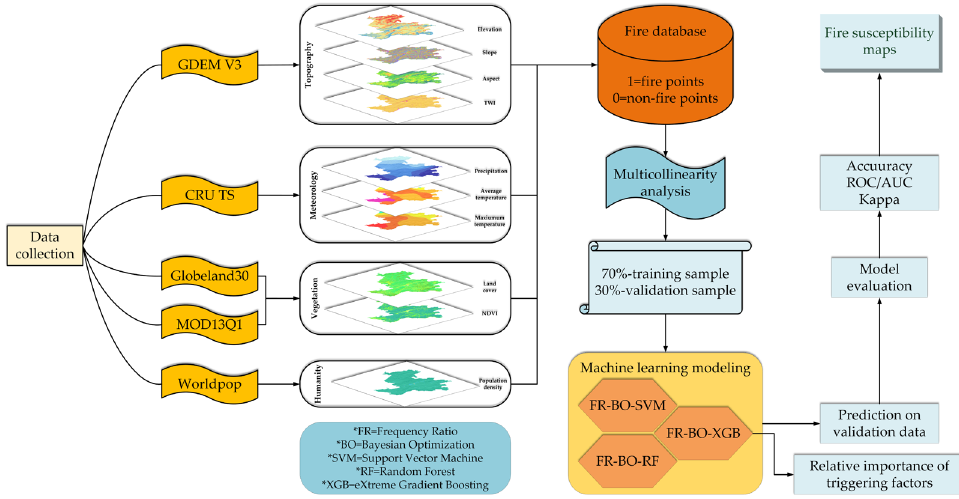
Figure 2. Technology